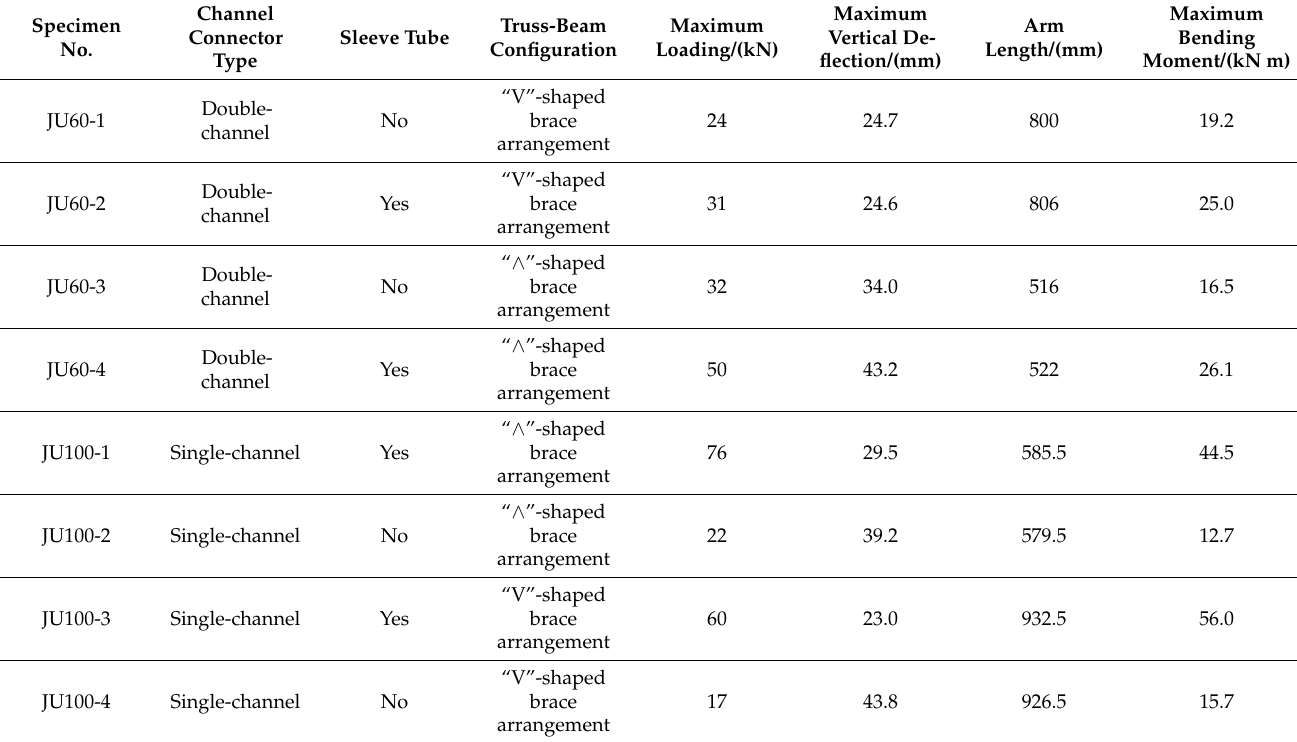
Table 3. The maximum loading and vertical deflection at the truss-beam